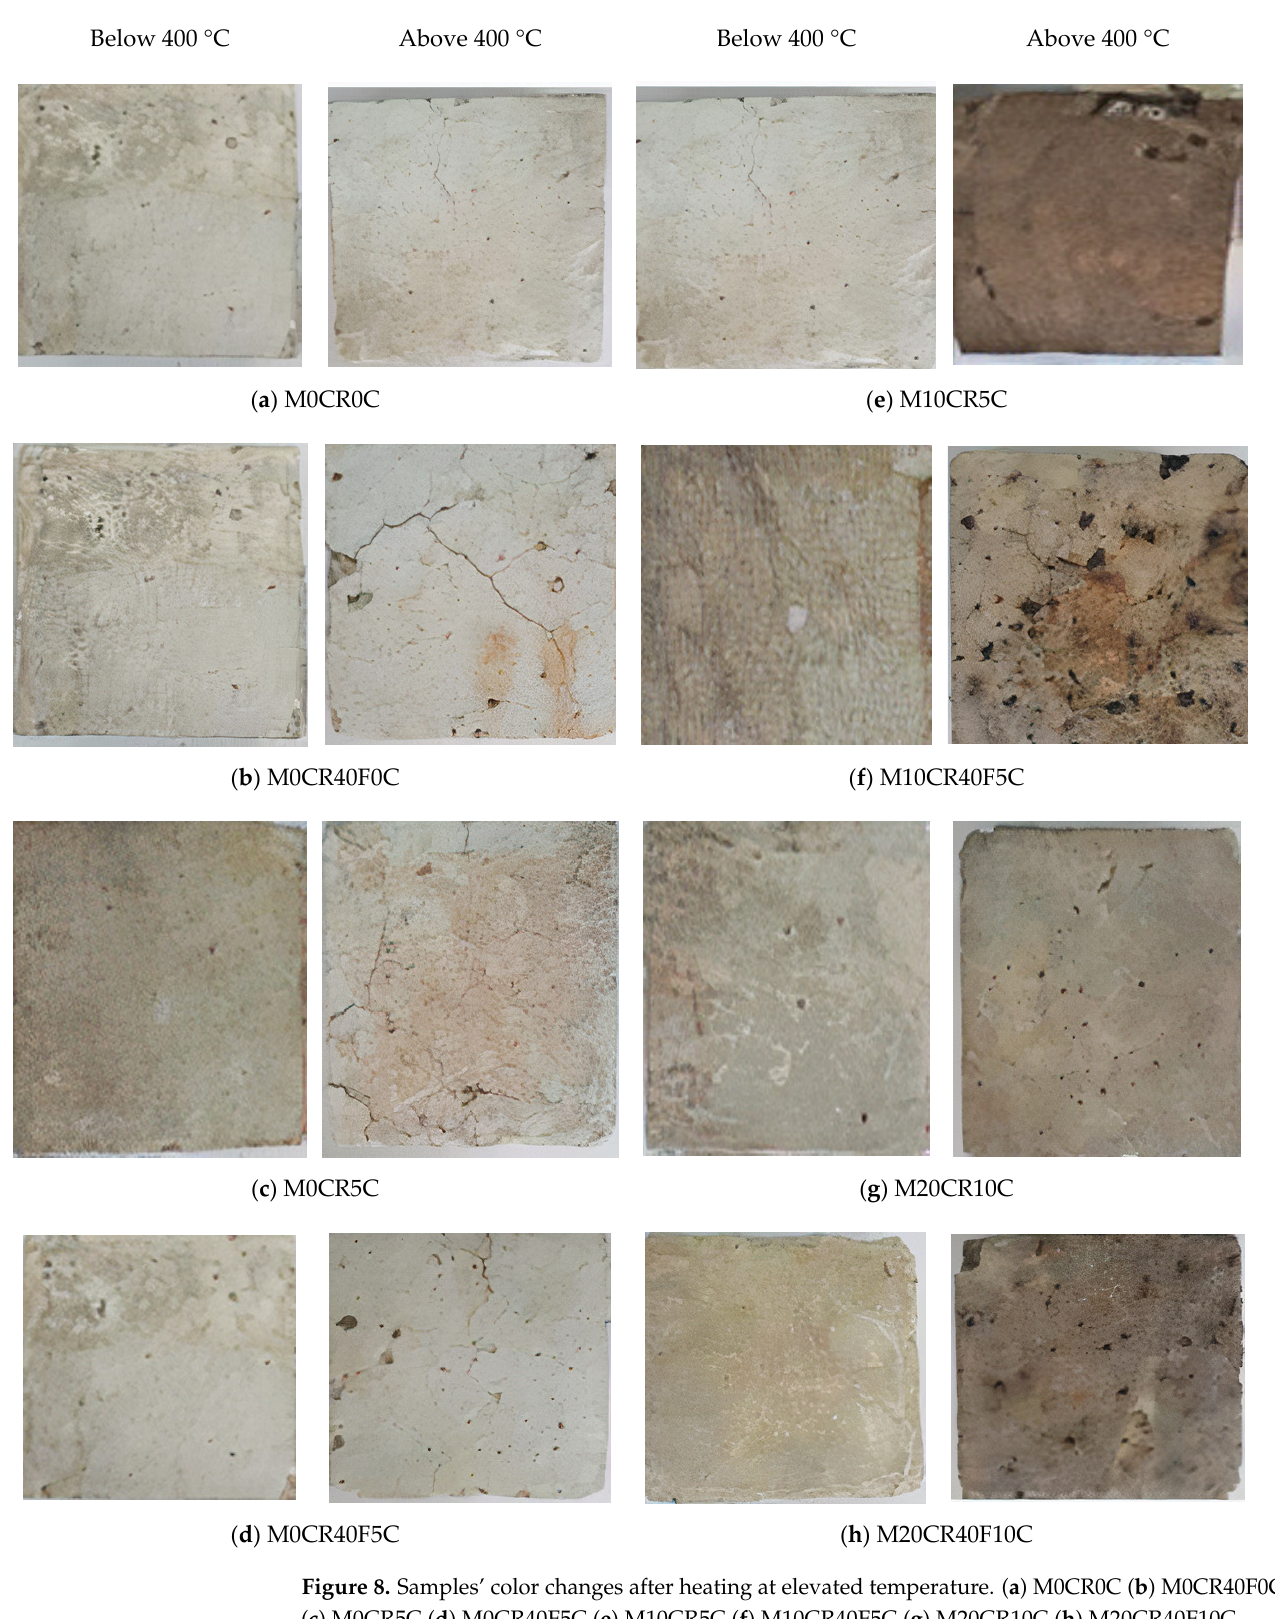
Figure 8. Samples’ color changes after heating at elevated temperature. ( a ) M0CR0C ( b )